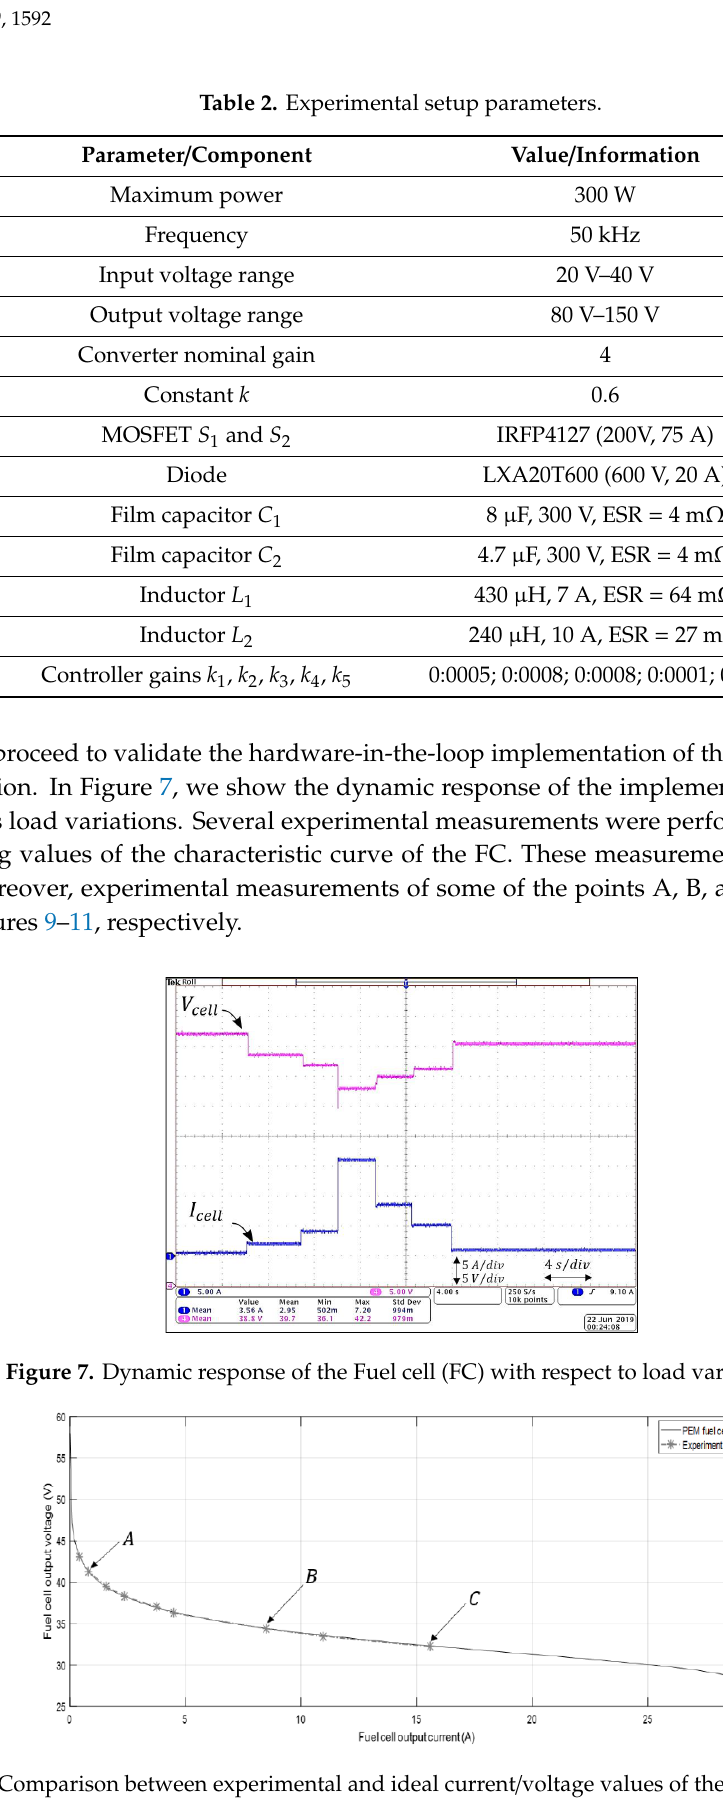
Table 2. Experimental setup parameters.